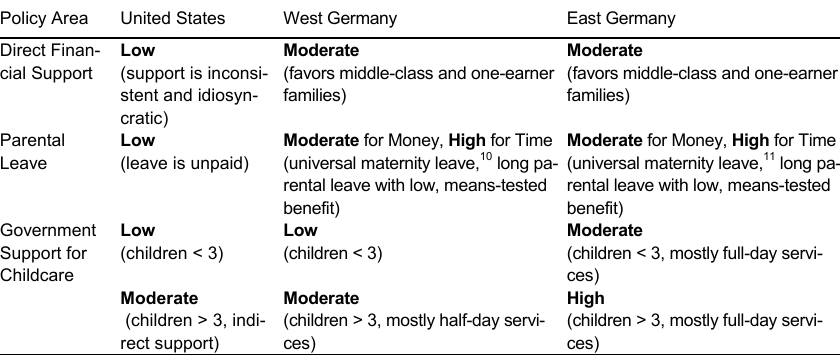
Table 1 Comparison of Policies that Provide Money or Time to Families in